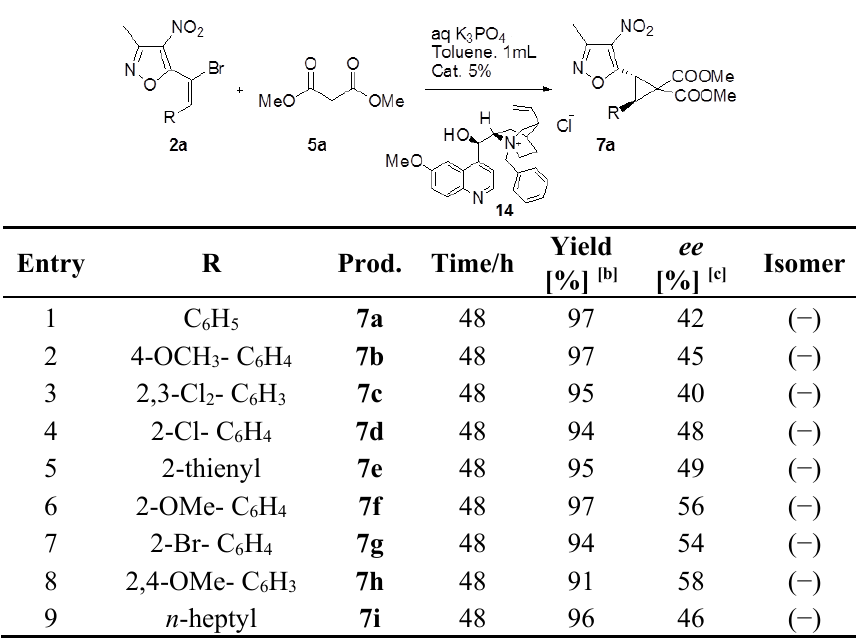
Table 3. Catalytic Asymmetric cyclopropanation of bromostyrylisoxazoles 2a–i with dimethyl malonate [a]